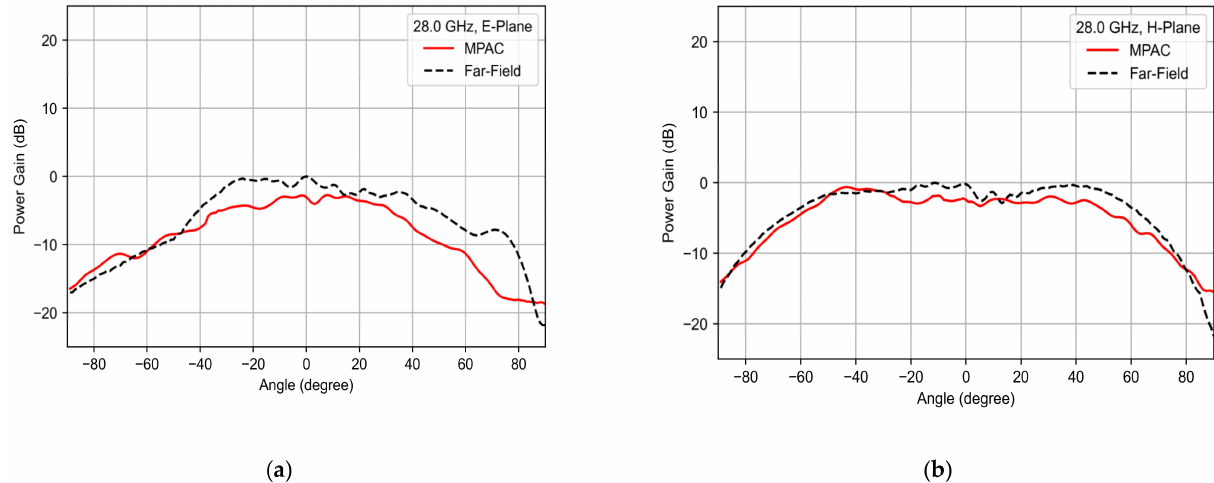
Figure 12. Radiation patterns of planar patch antenna at 28 GHz. ( a ) E-plane. ( b )